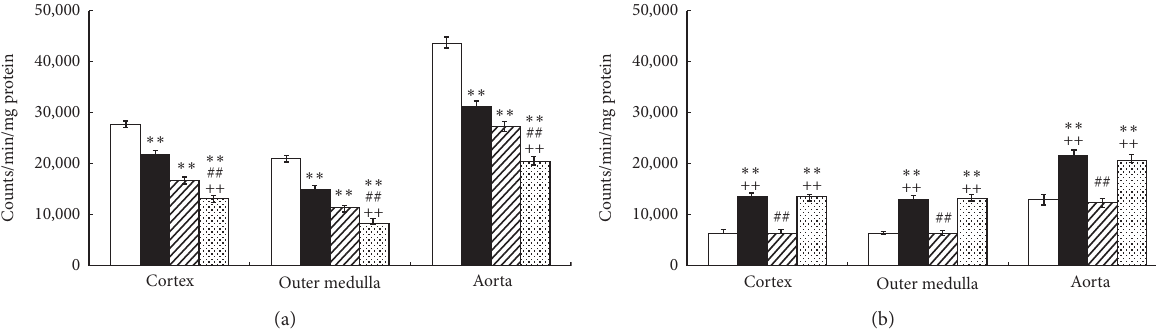
Figure 3: Effects of Ex and tempol on NADPH oxidase activity in SHR and WKY. The NADPH oxidase activity in the renal cortex, outer medulla, and aorta of SHR (a) and WKY (b) was compared among the control group (open bars), Ex group (closed bars), Tmp group (hatched bars), and Ex+Tmp group (checked bars) ( n � 10 in each group). ∗ P < 0 . 05 vs. the control group. ∗∗ P < 0 . 01 vs. the control group. ## P < 0 . 01 vs. the Ex group. ++ P < 0 . 01 vs. the Tmp